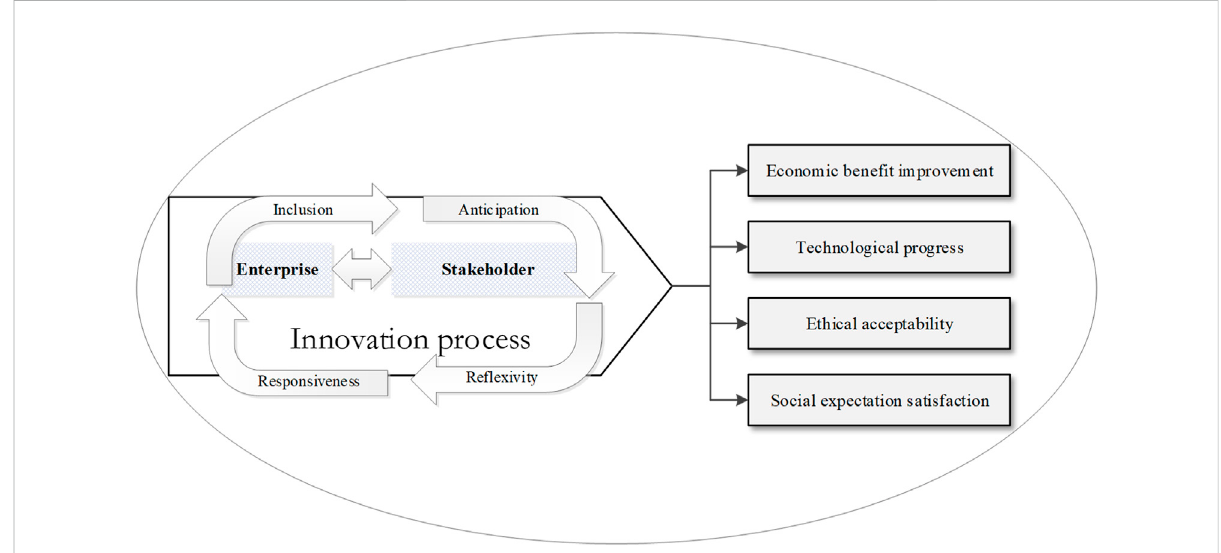
The concept map of corporate responsible